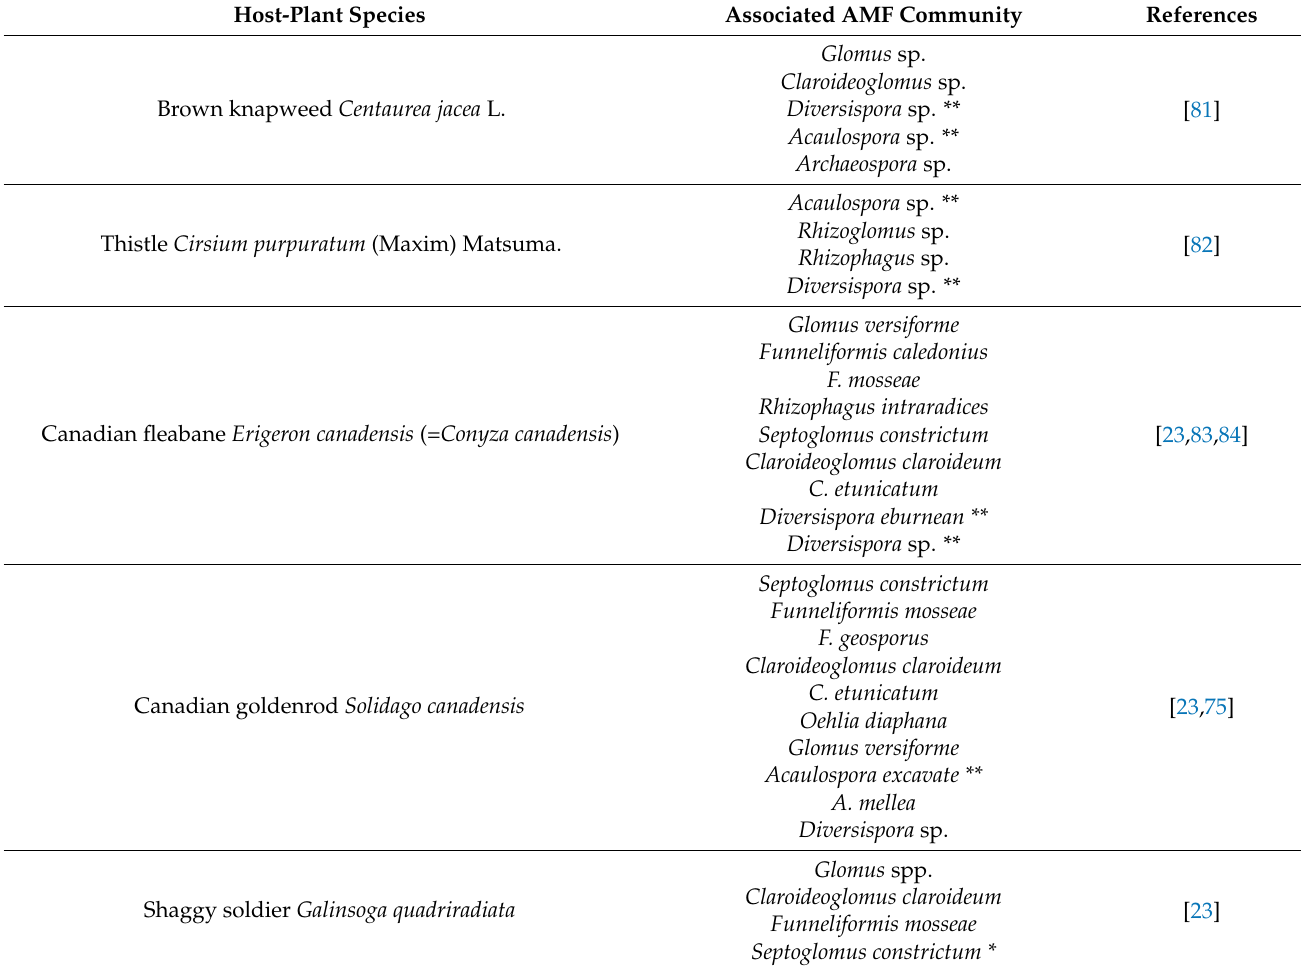
Table 2. Asteraceae plant species whose distribution is enhanced by